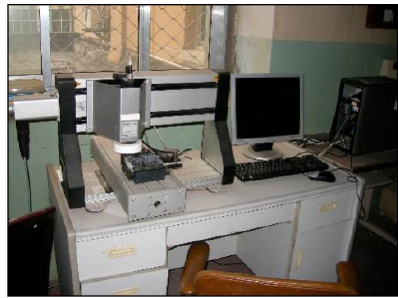
Figure 2. Air-void analyzer of hardened concrete.